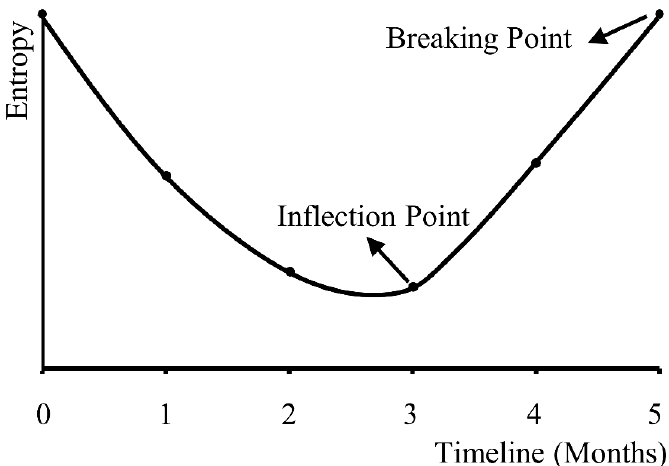
Figure 6: Variation in the entropy of the employees’ satisfaction with protection measures according to the perceptions of an employee for the Best-case